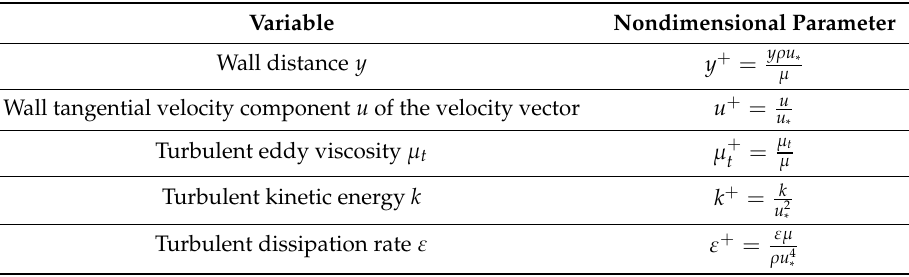
Table 3. Nondimensional